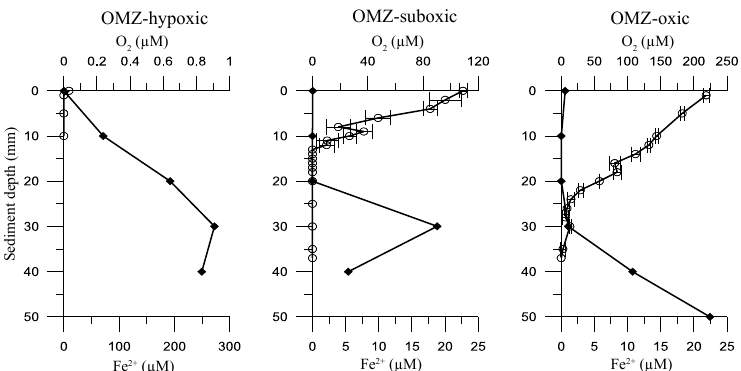
Fig. 3. Pore water oxygen (open circles) and Fe 2 + (closed diamonds) values measured in the OMZ transect multi-cores to show the position of the oxygen penetration depth. All O 2 values are shown with error bars depicting one standard deviation. Please note the different scales for both the O 2 and Fe 2 + values.